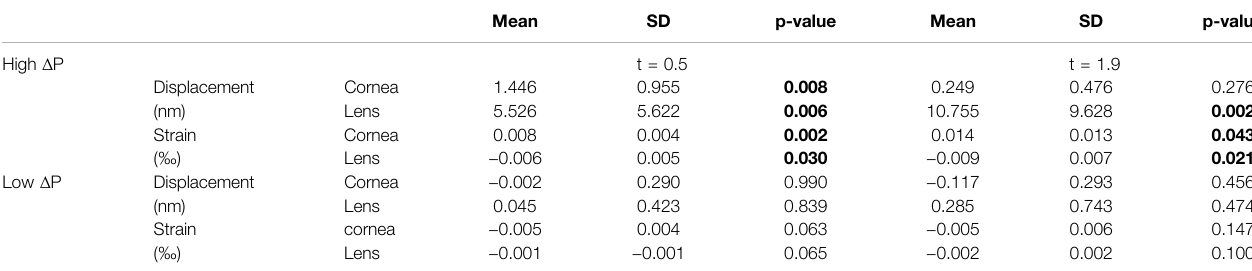
Bold text indicates statistical signi fi cance at p < 0.05.